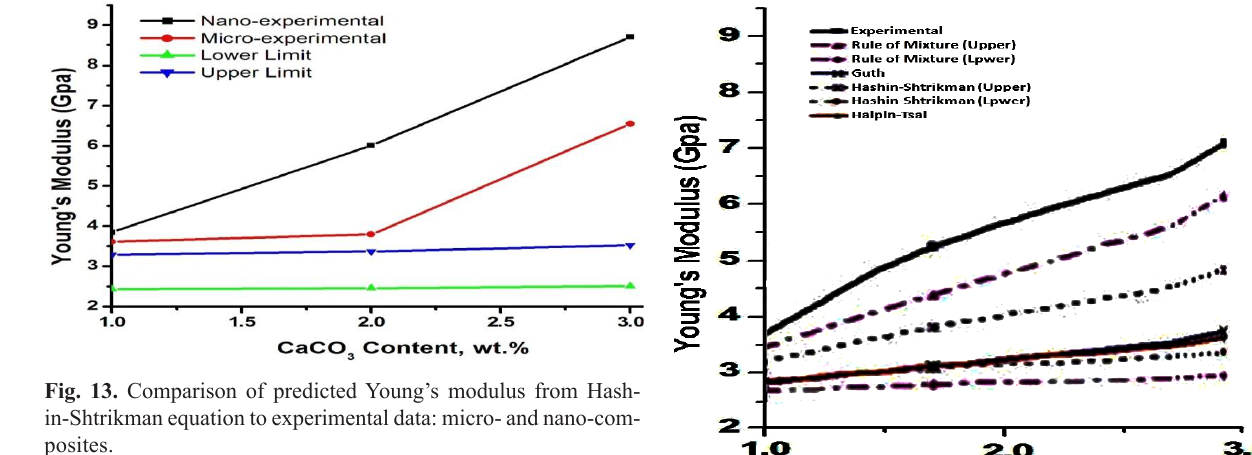
Fig.12. Comparison of predicted yield strength from Nico- lais-Narkis theory to experimental data: micro- and nano-compos- ites.